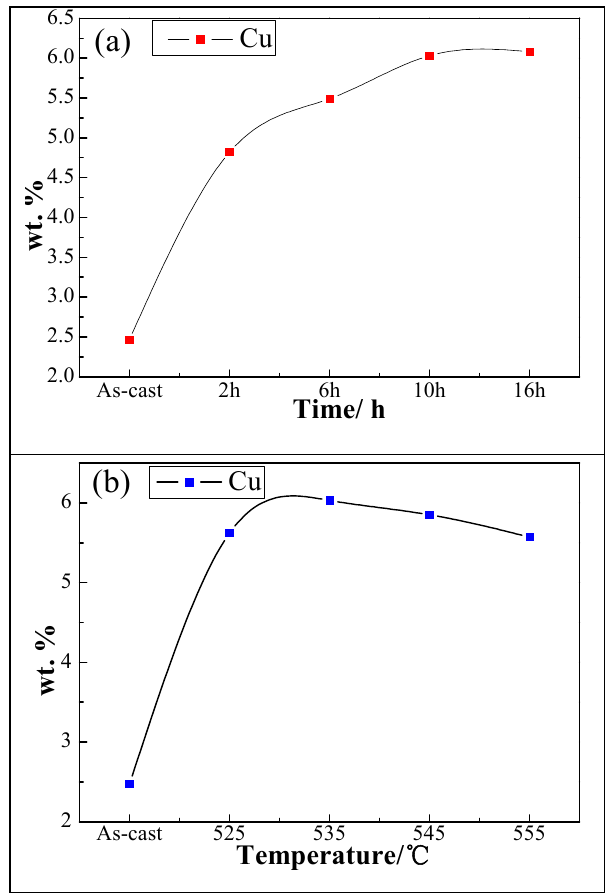
Figure 6. The concentration of Cu in the α (Al) matrix of as-cast and homogenized alloy: ( a ) Cu concentration in α (Al) matrix of homogenized alloy at different second-step time; ( b ) Cu concentration in α (Al) matrix of homogenized alloy at different second-step